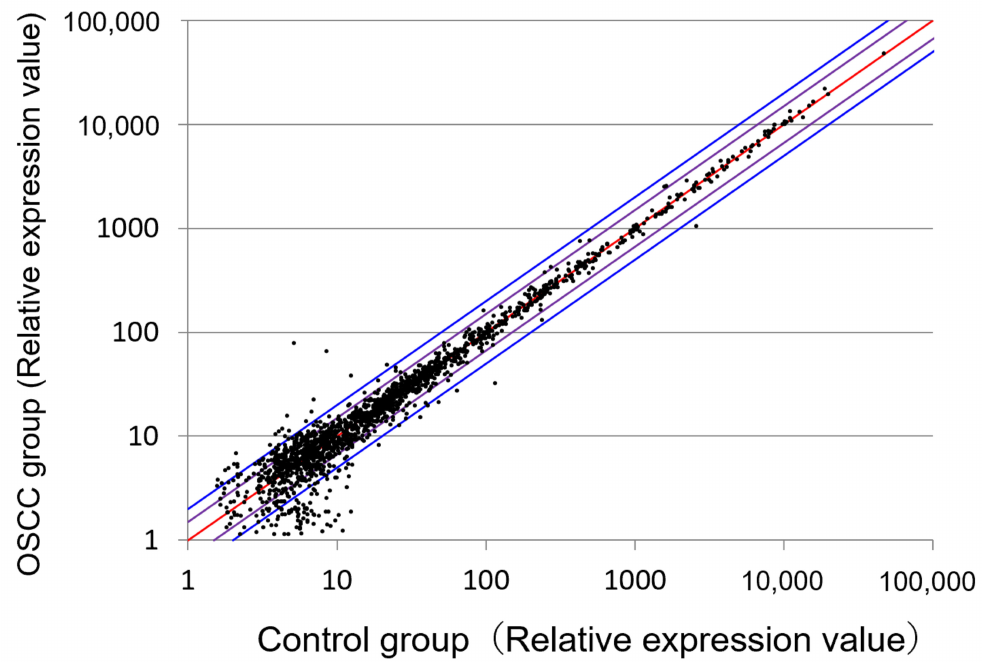
Figure 1. Comprehensive analysis of serum miRNA using a microarray. Microarray analysis detected 48 upregulated and 40 downregulated oral squamous cell carcinoma (OSCC)-specific miRNAs in patients, compared to healthy controls.